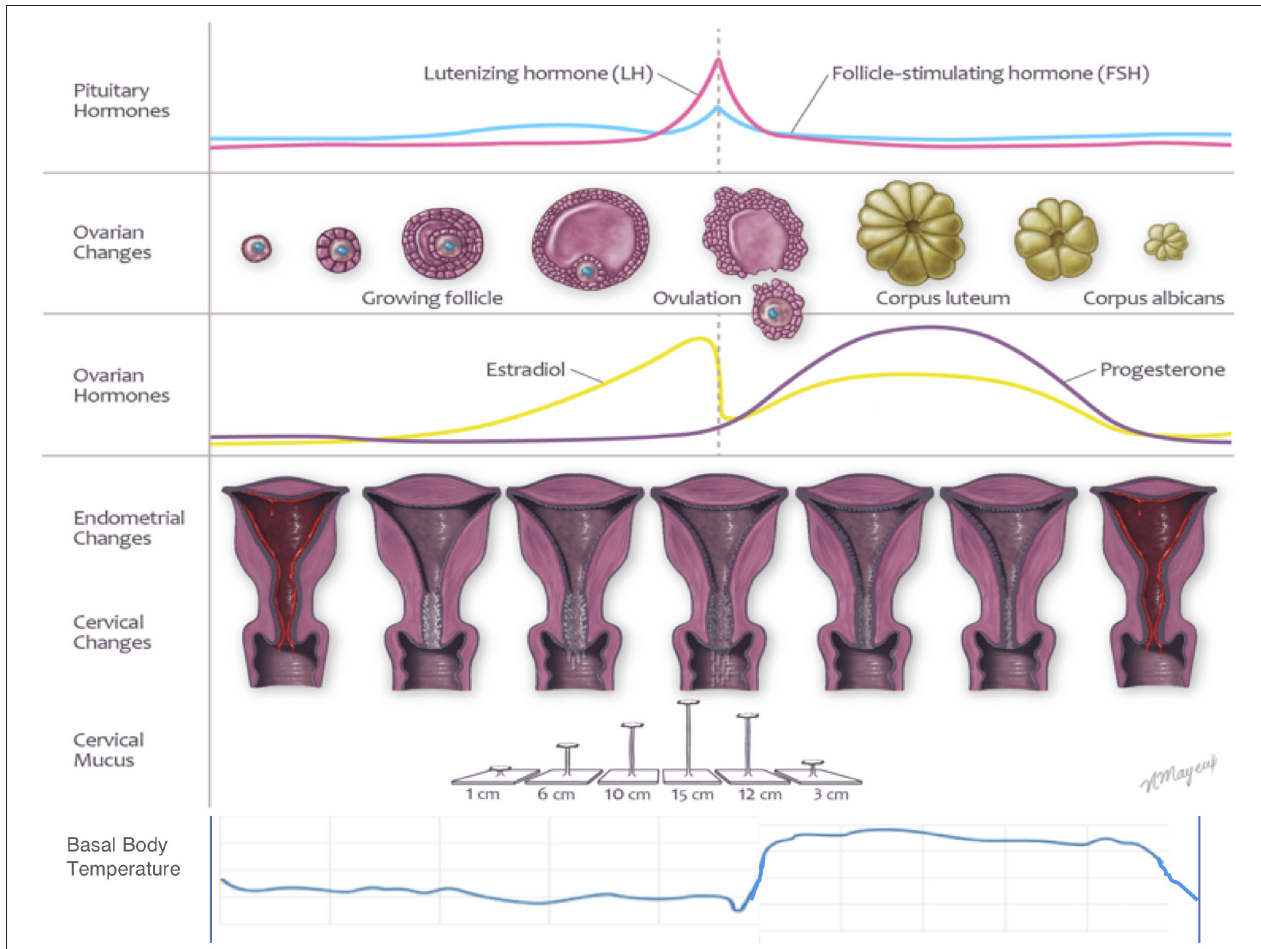
FIGURE 1 | Physiologic changes of the female